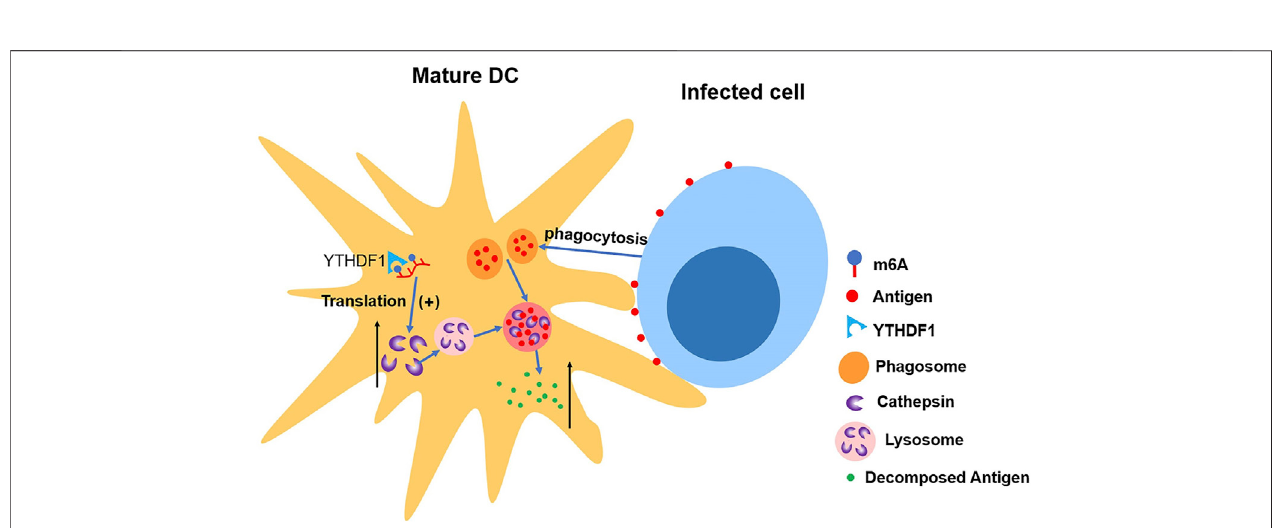
FIGURE 5 | YTHDF1 increases the level of cathepsin in mature DCs, which accelerates the cleavage of antigens in phagosome, making DCs ’ ability of presenting antigen impaired.